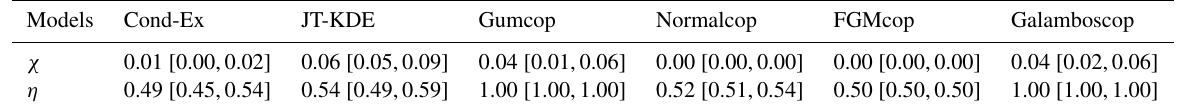
Table 5. Estimates of dependence parameters χ and η for extreme rainfall and wind gust at Heathrow Airport for the time range 1971–2018.